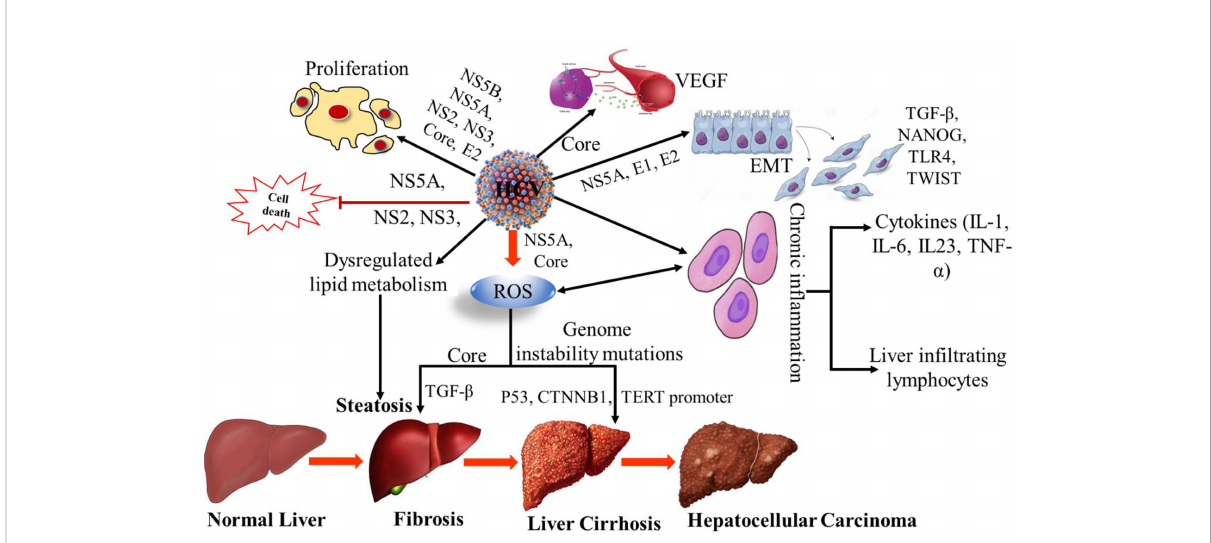
FIGURE 1 Mechanism of HCV induced hepatocellular carcinoma. VEGF, Vascular endothelial growth factor; EMT, Epithelial – mesenchymal transition; TGF- b , Transforming Growth Factor- b ; TLR4, Toll-like receptor 4; TWIST, Twist-related protein; ROS, Reactive oxygen species; CTNNB1, Catenin Beta 1; TERT, Human telomerase reverse transcriptase; TNF- a , Tumor necrosis factor alpha; NS, non-structural; IL-1; Interleukin-1, IL-6; Interleukin 6, IL-23,